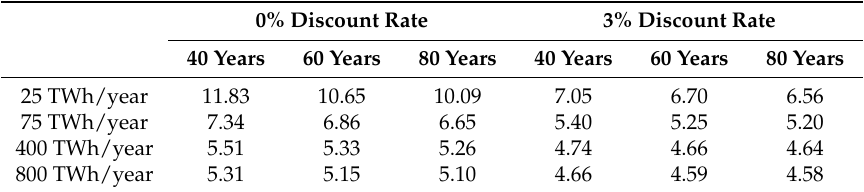
Table 1. Levelized cost of electricity (LCOE) for once-through fuel cycle (OFC) in different scenarios in $(2010)/MWh. in $(2010)/MWh.